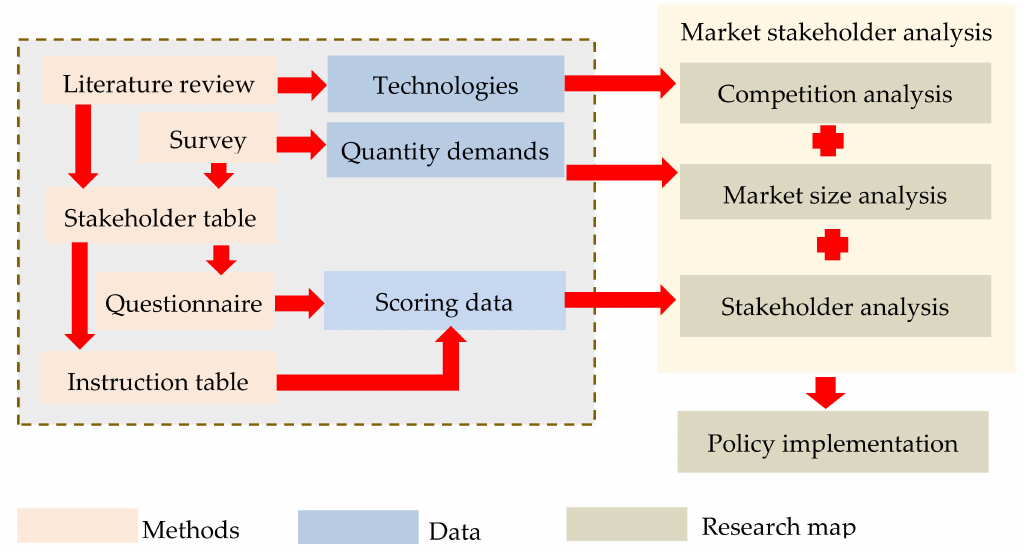
Figure 1. Method, data, and research